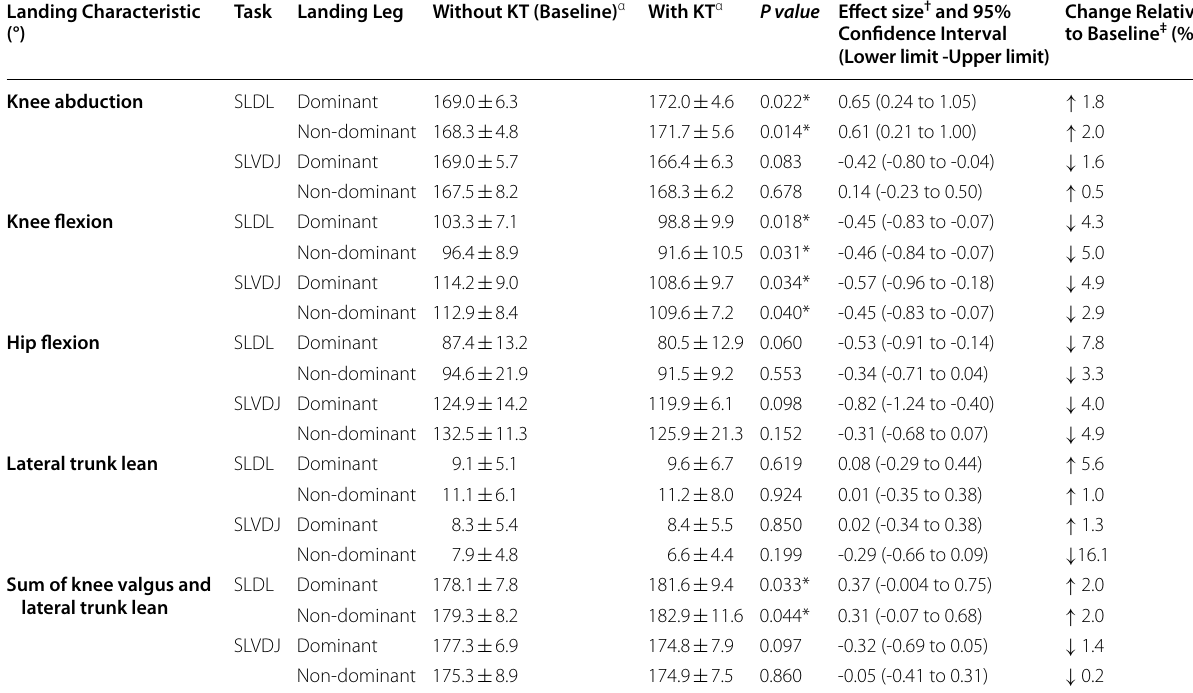
Table 2 Within‑group changes in peak angles of knee abduction, knee flexion, hip flexion, lateral trunk lean, sum of knee valgus and lateral trunk lean during SLDL, SLVDJ